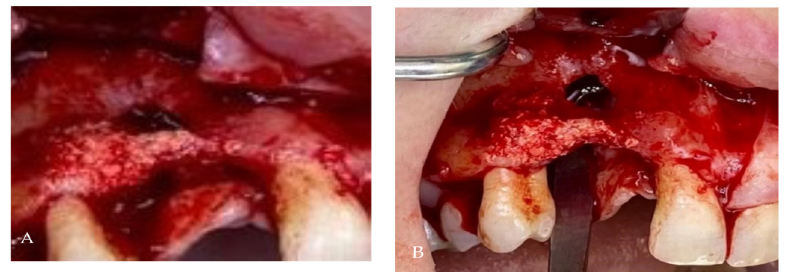
Figure 6. Intraoperative oral images: ( A ) the defect interested the entire width of the bone, situated at the apical level of the neighbored teeth, ( B ) a marginal of 2 mm particles augmented.